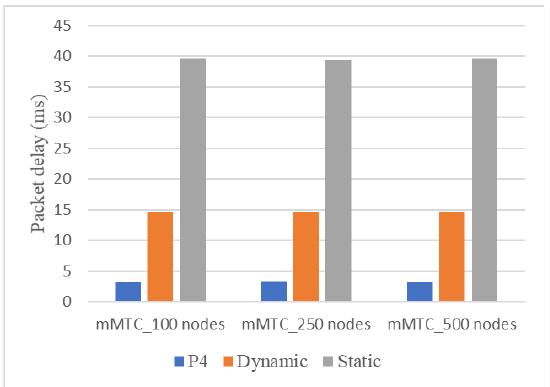
Figure 13. Average packet delay in the URLLC slice.